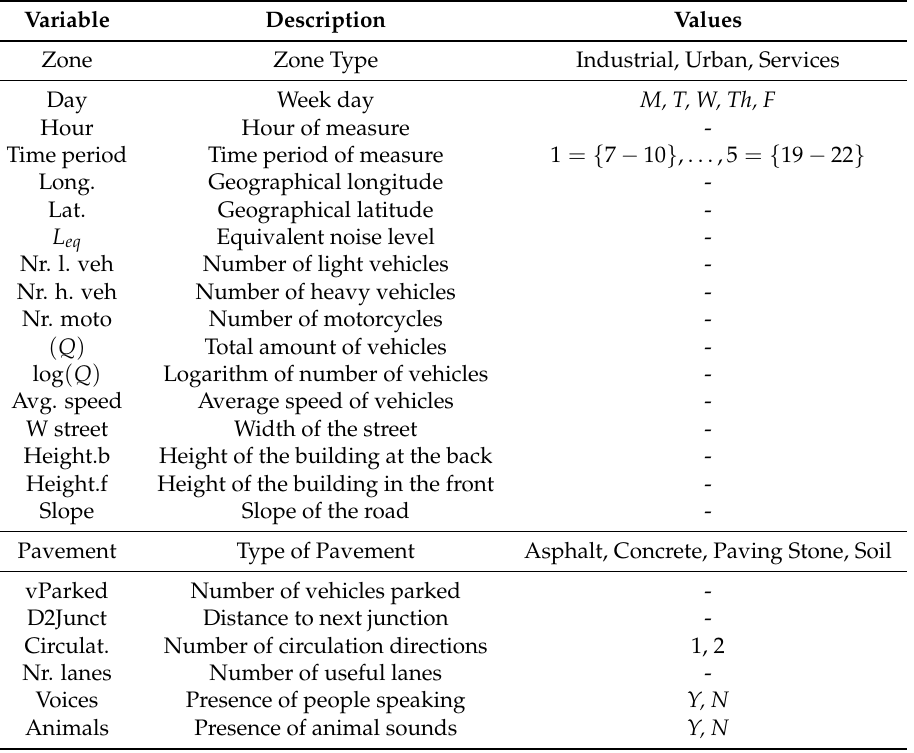
Table 1. Variables used.